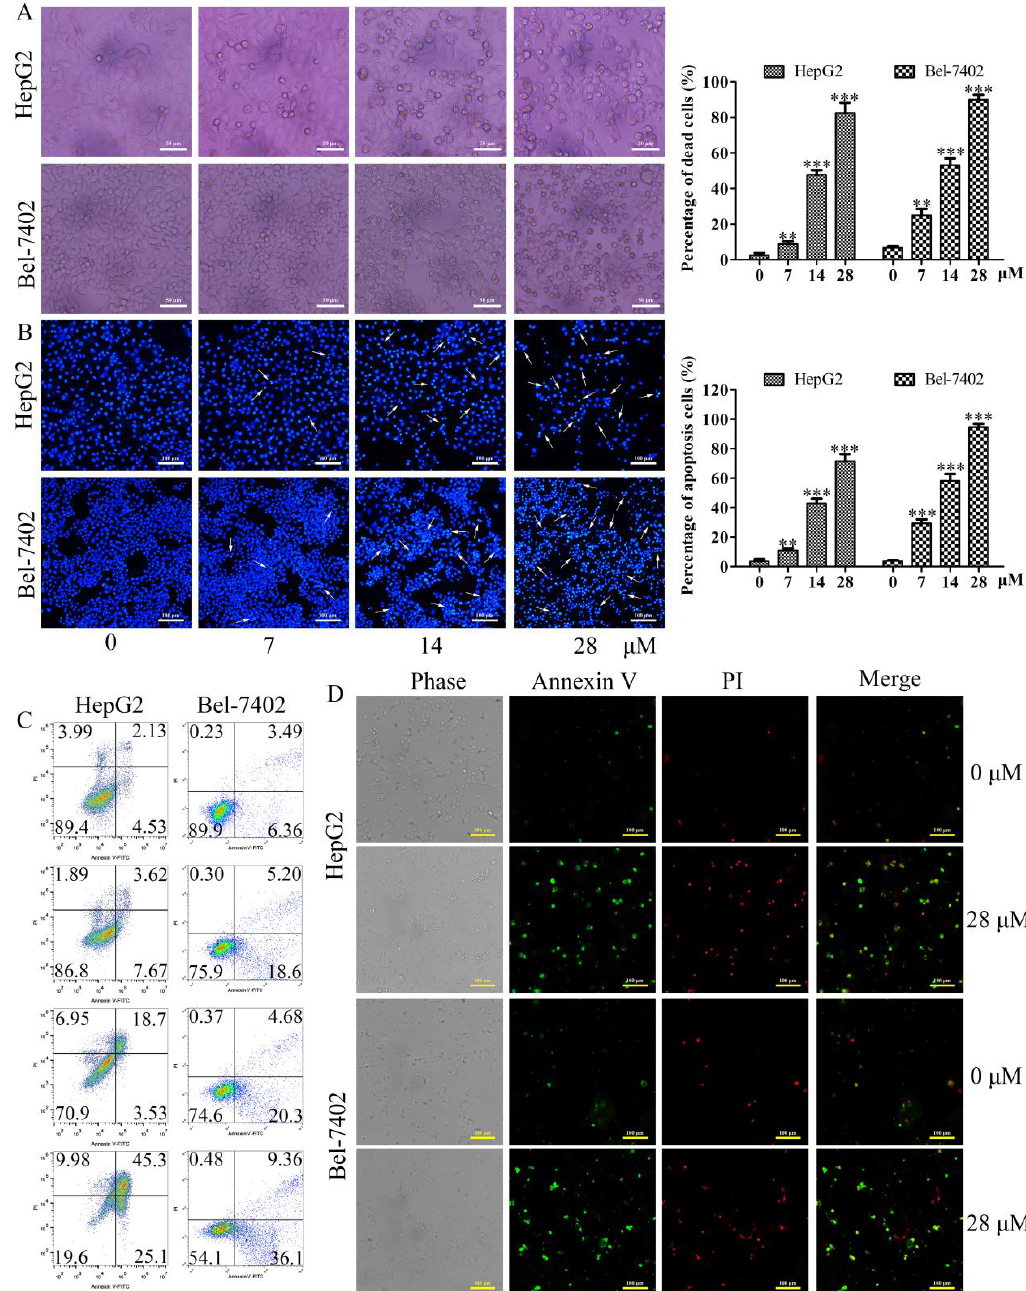
Figure 3. Morphological changes and apoptosis changes of HepG2 and Bel-7402 cells were treated with Davidone C. ( A , B ) Hoechst 33258 was used to photograph the morphology of HepG2 and Bel-7402 cells under a fluorescence microscope (80 × ); ( C, D ) HepG2 and Bel-7402 cells were treated with Davidone C for 12 h, then stained with Annexin V/PI, then evaluated by flow cytometry, and photographed under a fluorescence microscope (80 × ) (** p < 0.01, *** p < 0.001). To check whether davidone C can induce apoptosis in HepG2 and Bel-7402 cells After staining (Figure 3B), compared with the drug group, the blank group had com- after 12 h, the cells were stained with Annexin V-FITC and analyzed by flow cytometry. plete cells and uniform staining. Apoptosis, chromatin agglutination, fragmentation, and bright apoptotic bodies appeared in the drug group, especially in the high-dose group. The experimental data takes Annexin V as the horizontal axis and PI as the vertical axis. The upper left quadrant is mechanically damaged cells, the upper right quadrant is late apoptotic or necrotic cells, the lower left quadrant is negative normal cells, and the lower right quadrant is early apoptotic cells. Compared with the control group, the percentage of apoptosis of HepG2 cells was significantly increased after davidone C at